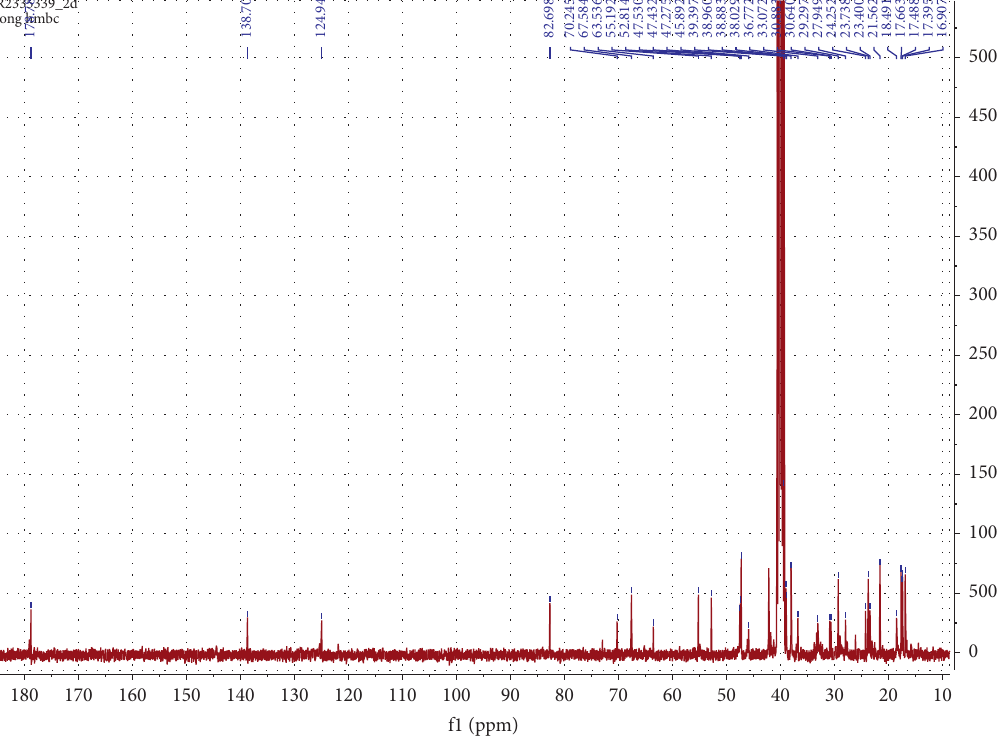
Figure 3: 13 C NMR (DMSO, 100MHz) spectrum of tormentic